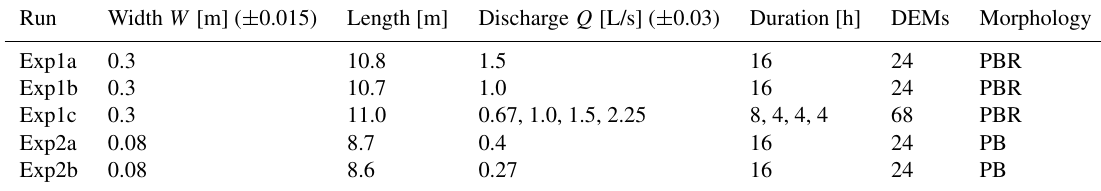
Table 1. Summary of experimental conditions in the A-BES. Length refers to the median length of DEMs, which generally varies by ± 0 . 1m and does not include approximately 20–30cm of bed at the upstream end. The DEM count excludes the screeded bed which has no associated hydraulic